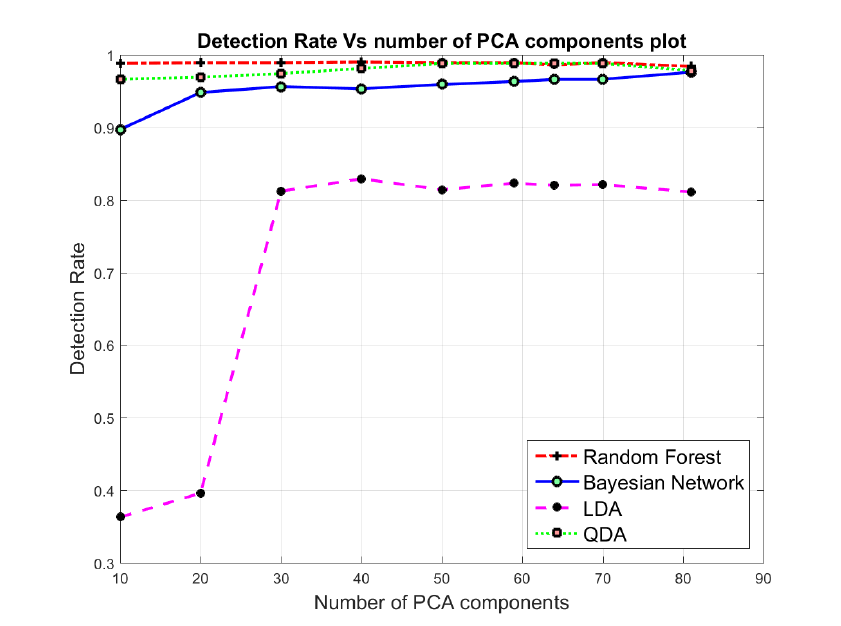
Figure 3. Binary Class Classification: Detection Rate in terms of number of components using PCA.